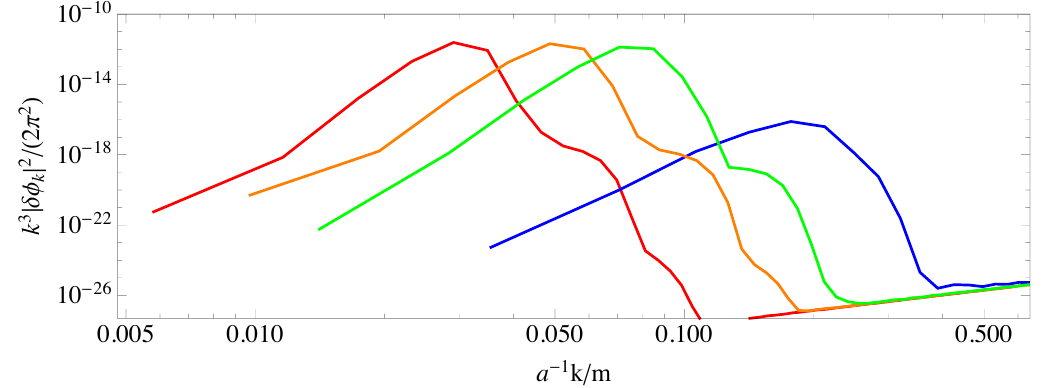
Figure 5 . The spectrum of (cid:30) (cid:13)uctuations as a function of the physical momentum a (cid:0) 1 k=m obtained from a lattice simulation of the KKLT model with W 0 = 10 (cid:0) 12 . The di(cid:11)erent colours correspond to di(cid:11)erent moments in time: a = 2 : 29 (blue), a = 5 : 76 (green), a = 8 : 36 (orange) and a = 14 : 03 (red).